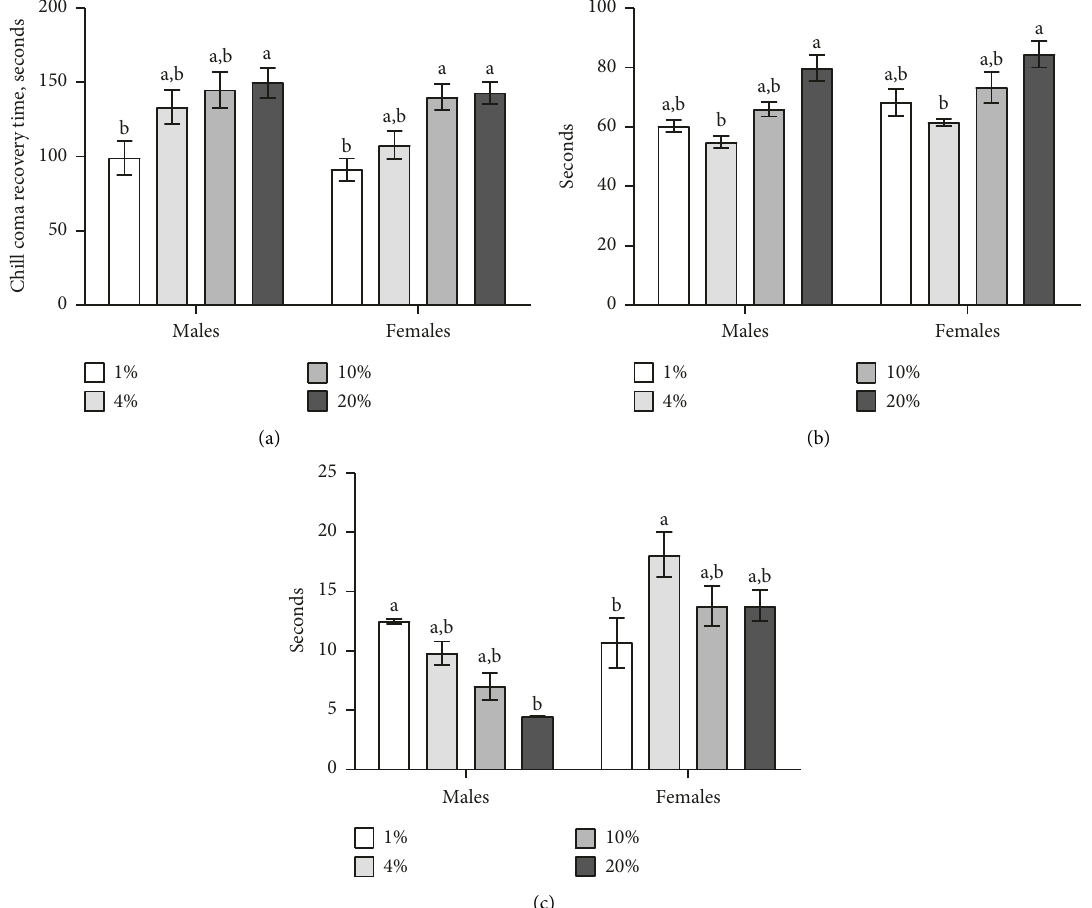
Figure 2: Sensitivity toward cold (a) and heat-induced stress ((b time required to full fly immobility and referred as heat paralysis; (c) time needed for the full recovery of locomotion). Results are presented as mean ± SEM, n � 10. Values were compared by Tukey’s test: a indicates the highest values among all tested groups, and b indicates significant difference from a, with p < 0 .